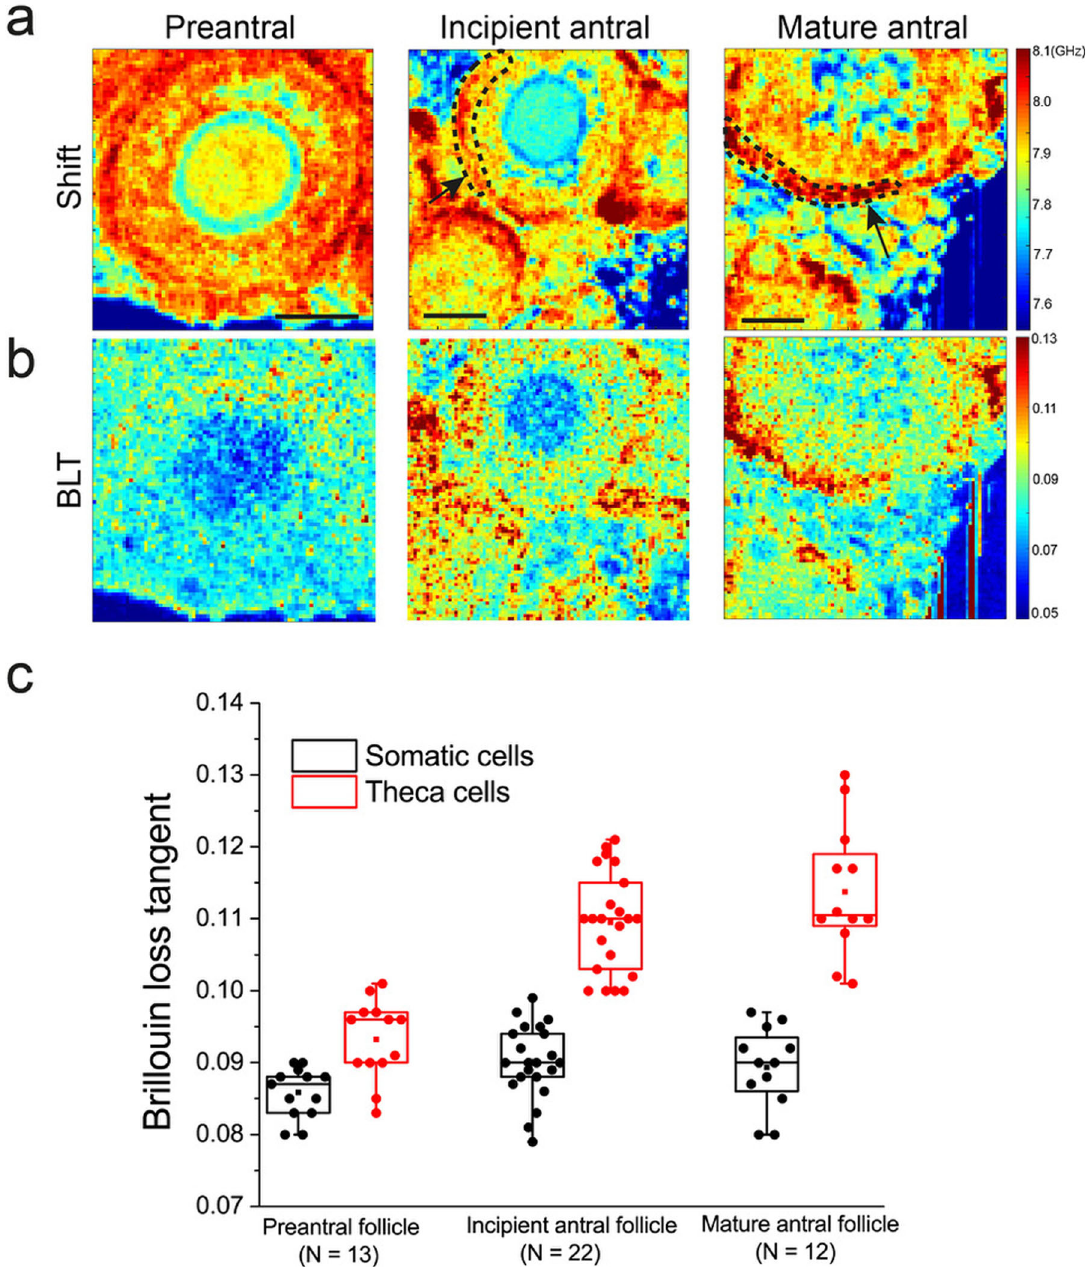
Fig. 3 Distinct mechanical compartments emerge during follicle maturation. a Row shows representative maps of Brillouin shift for follicles at distinct stages of folliculogenesis. Scale bar = 40 μ m. b Corresponding maps of BLT for a . c Boxplot of BLT for the outer theca cells versus the inner somatic cell layer of follicles at various stages of development. Each data point corresponds to the average signal of somatic or theca cells in one follicle. Black arrows indicate the follicles under consideration, black dashed lines indicate the region of interest for the theca cell